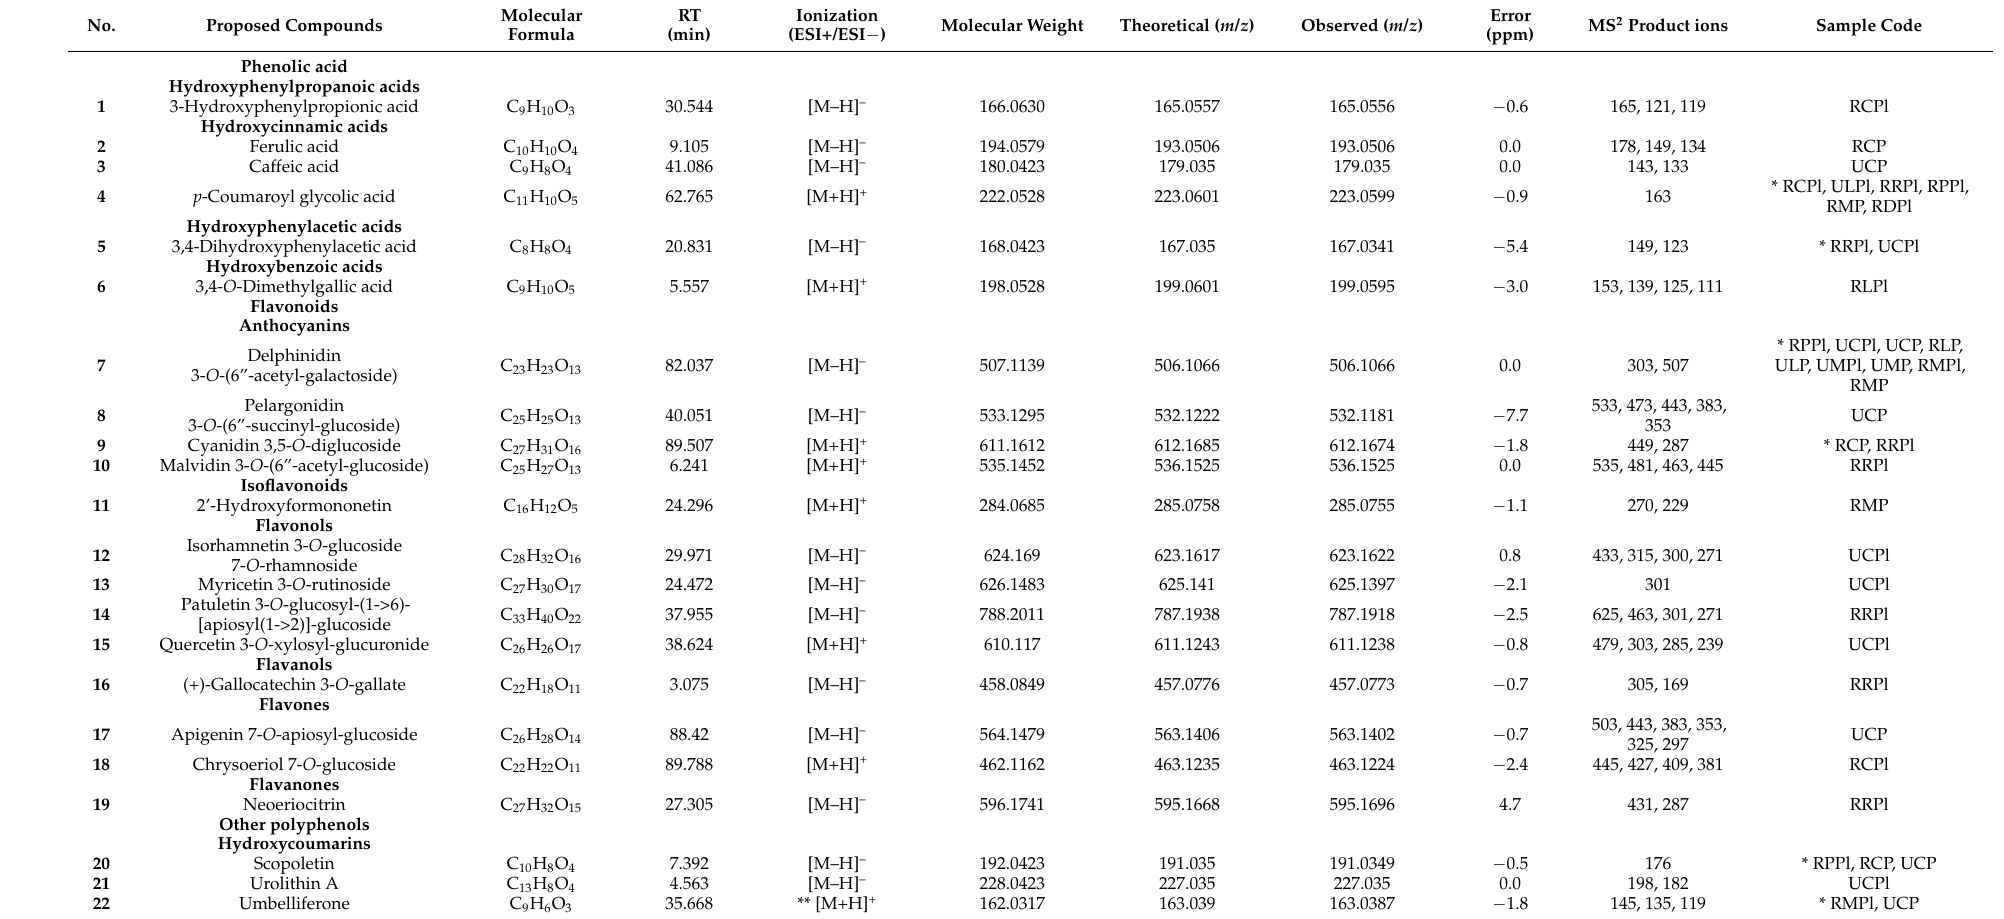
Table 4. Characterization of phenolic compounds from different banana cultivars by